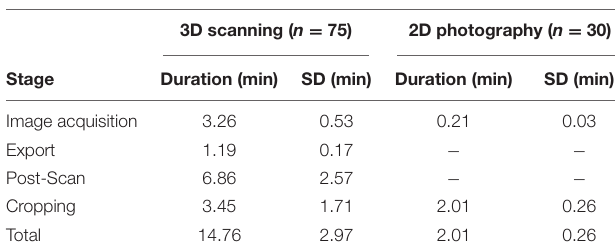
TABLE 2 | Average time required for an experienced operator to complete each stage of coral scanning and processing or